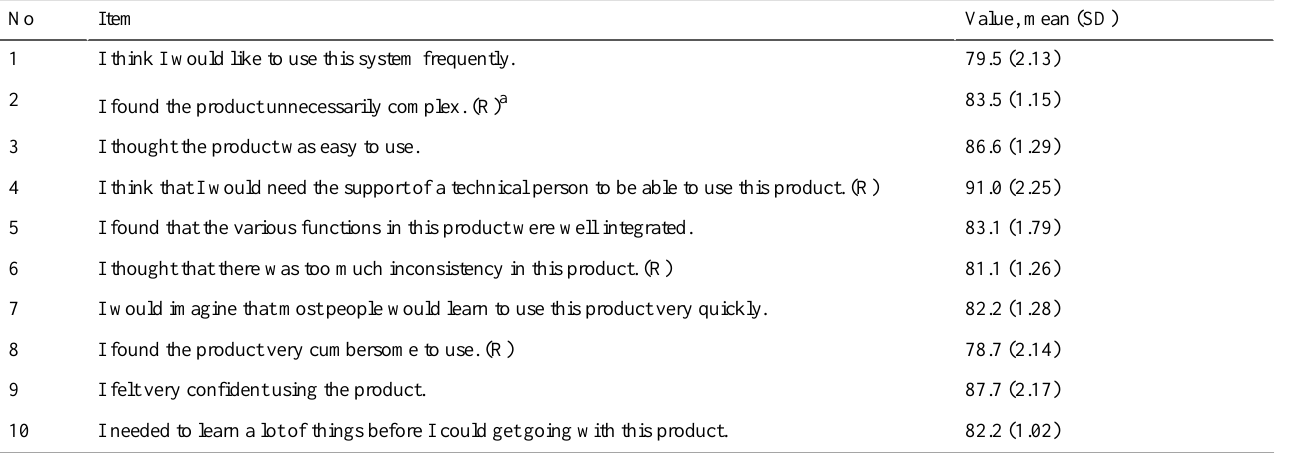
Table 5. Descriptive statistics of the System Usability Scale